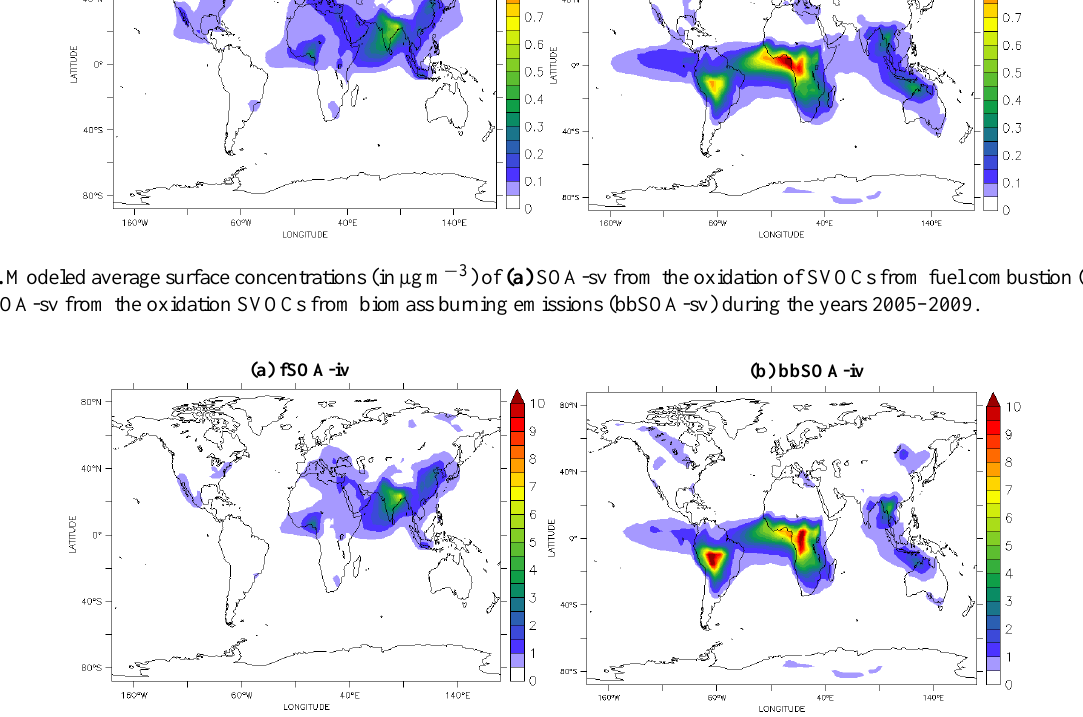
Figure 7: Modeled average surface concentrations (in μg m -3 ) of (a) SOA-iv from the oxidation 1254 Figure 7. Modeled average surface concentrations (in µgm − 3 ) of (a) SOA-iv from the oxidation of IVOCs from fuel combustion (fSOA-iv) of IVOCs from fuel combustion (fSOA-iv) and (b) SOA-iv from the oxidation of IVOCs from 1255 and (b) SOA-iv from the oxidation IVOCs from biomass burning emissions (bbSOA-iv) during the years biomass burning emissions (bbSOA-iv) during the years 2005-2009. 1256